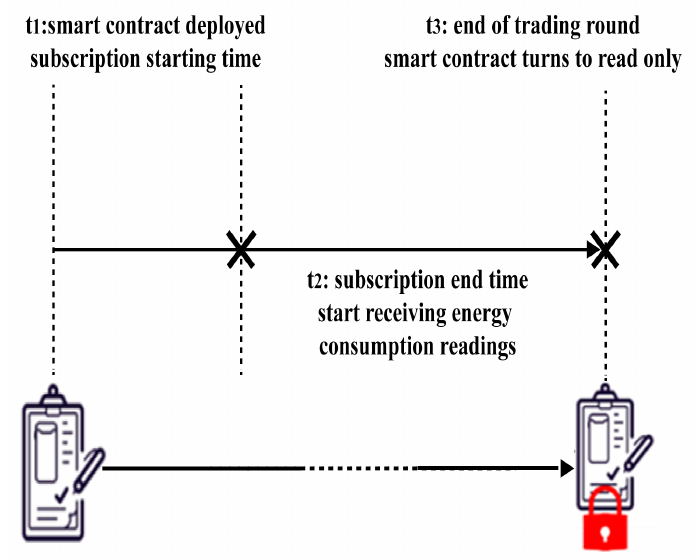
Figure 8. Time dependency of the Provider smart contract